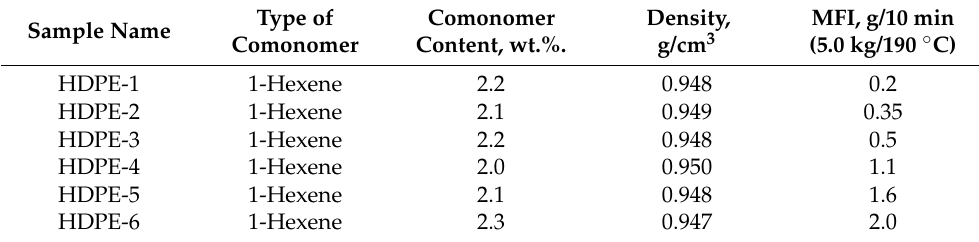
Table 1. Characteristics of high-density polyethylene